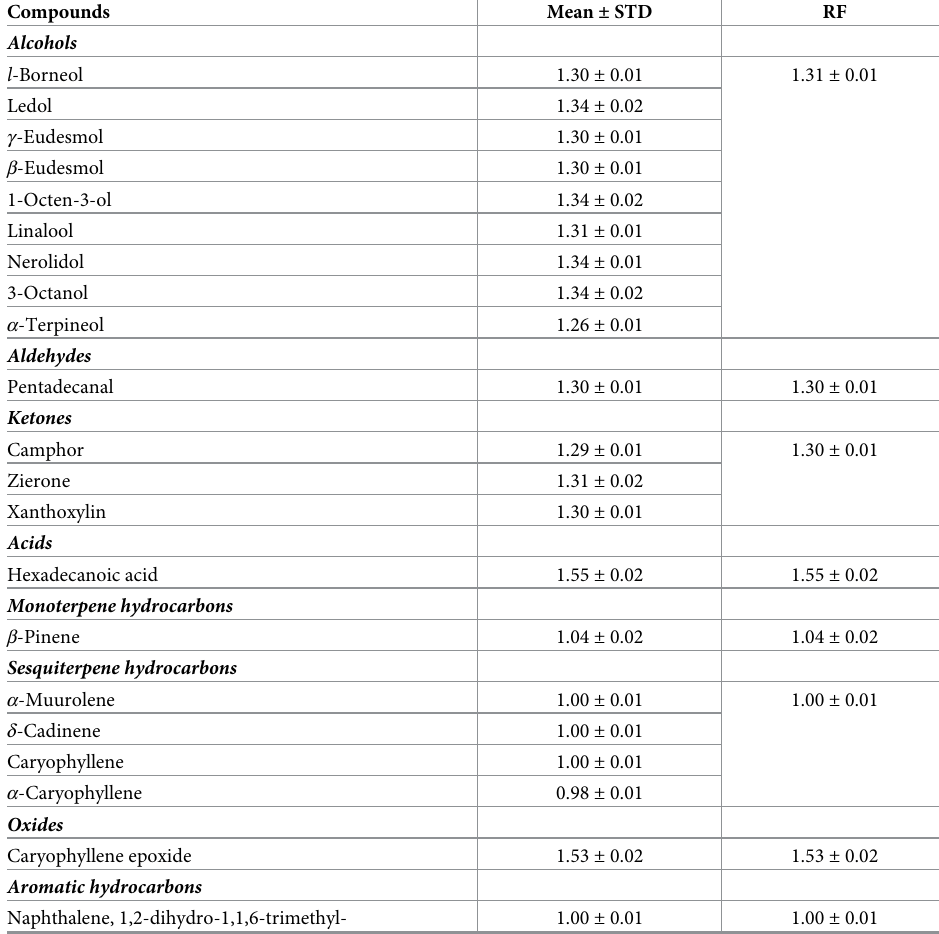
Table 1. Response factors (RFs) of different